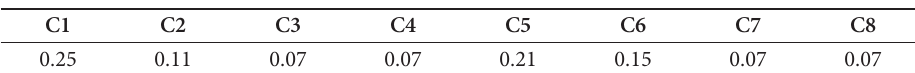
Table 4. Criteria